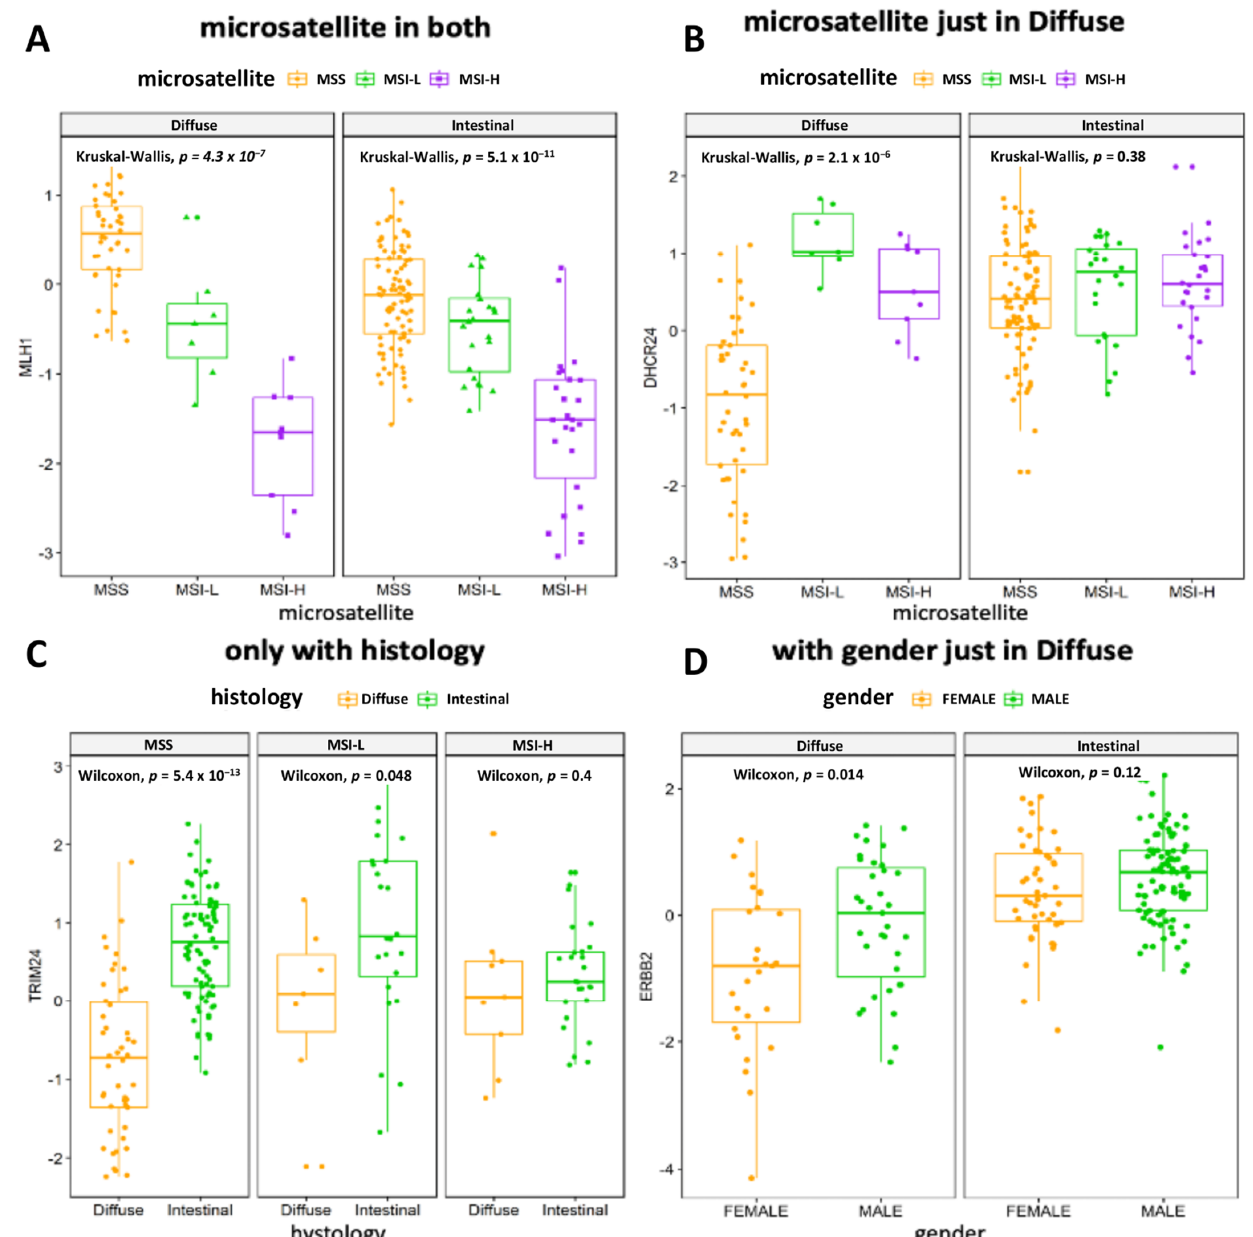
Figure 3. Boxplots of selected significant associated ssMRs NES and clinical features. ( A – C ) Relationships among microsatellite, histotype and different MRs. ( D ) Highlight of a gender-associated MR in the Diffuse subgroup. NES on the y-axis examples is how much regulon is active. Wilcoxon test informs the association of the clinical feature with MR.